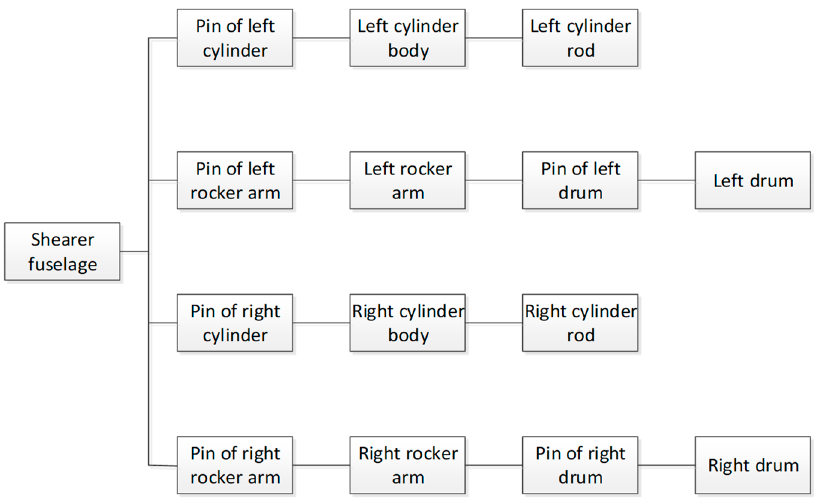
Figure 10. Parent–child relationship of shearer components.